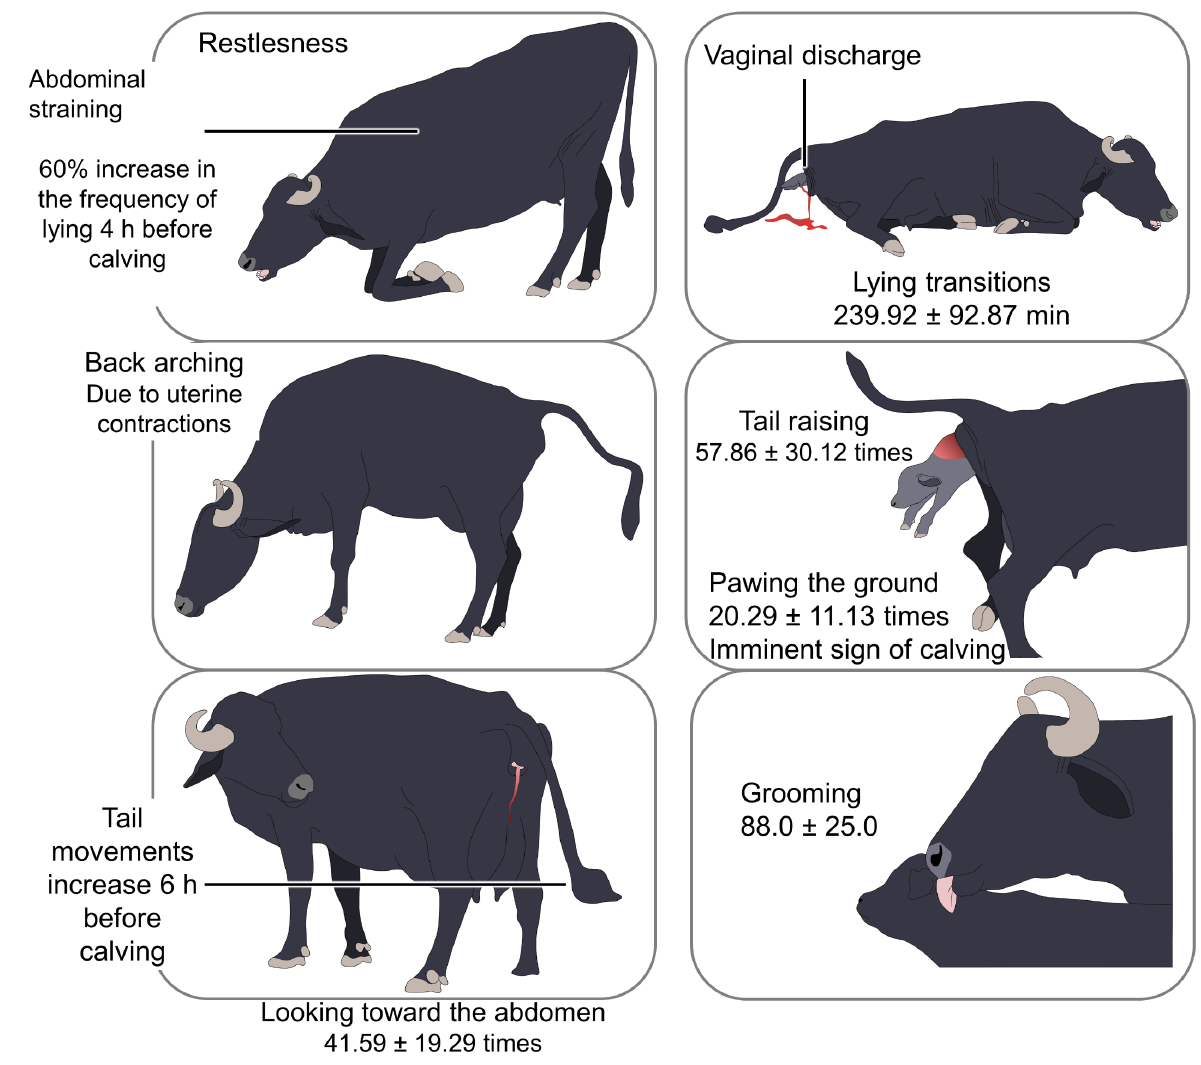
Figure 1. Main behavioral patterns during parturition in water buffalo. The exhibition of restlessness, back arching, and tail movements are considered good behavioral signs of the onset of parturition. Lying transitions, tail raising, or grooming are patterns observed during the last parturition stage, and their frequency or time of duration (assessed for 11 h pre- calving and expressed as number of times or min in the pictures) increases during